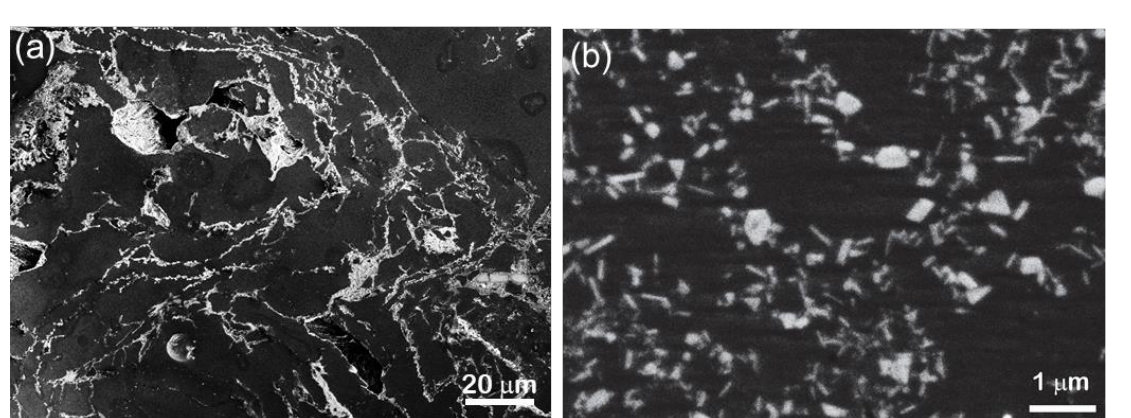
Figure 32. Morphology of native γ -Al 2 O 3 films/particles in CP-Al [75,86]. SEM micrographs showing the general view of ( a ) γ -Al 2 O 3 films at low magnification and ( b ) the discrete γ -Al 2 O 3 particles collected from commercial purity Al (CP-Al) at 750 °C by melt filtration.